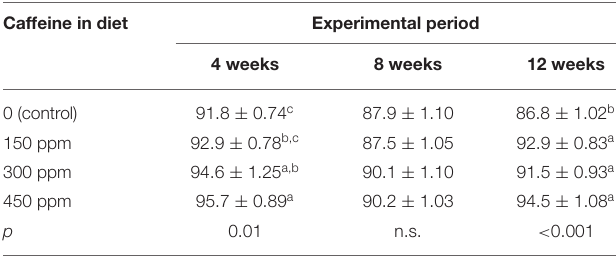
TABLE 5 | Haugh units of the eggs produced by laying hens fed rations containing different concentrations of caffeine for 12 weeks. Caffeine in diet